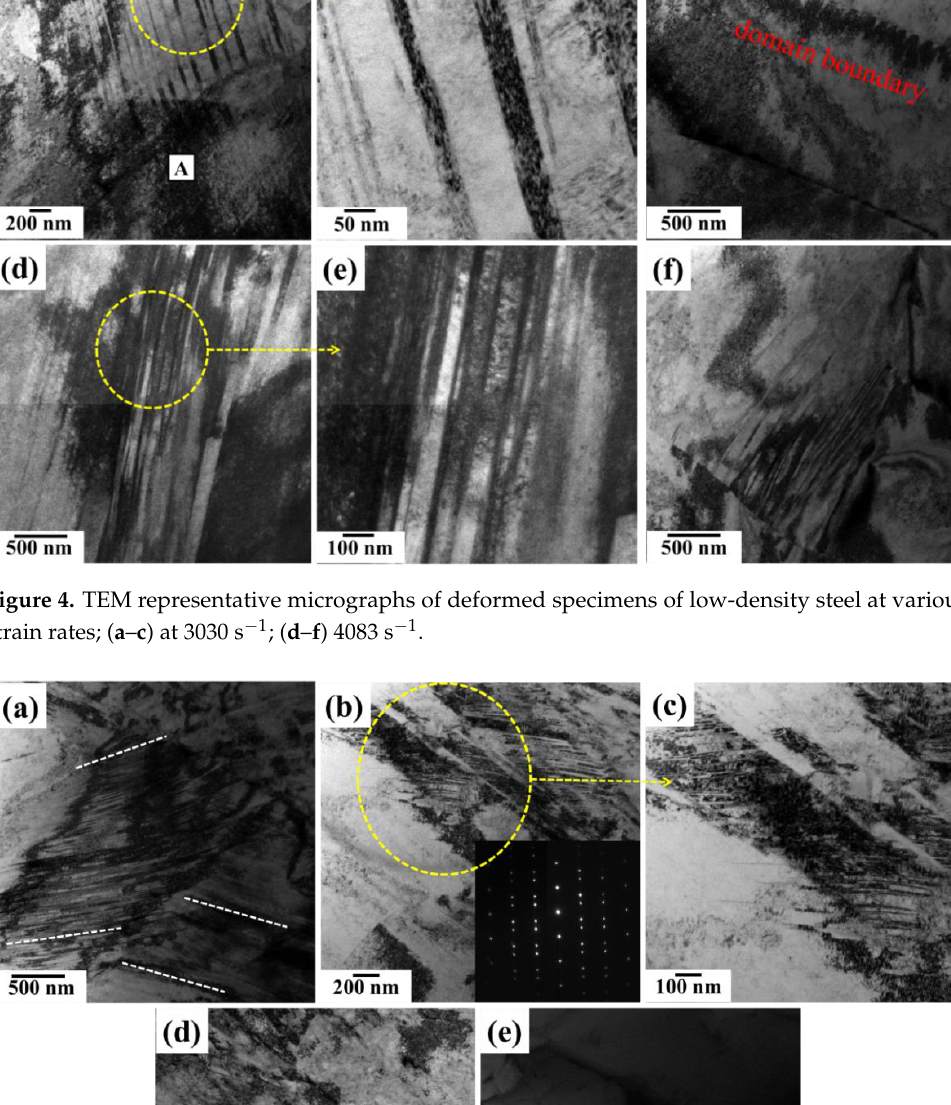
Figure 4. TEM representative micrographs of deformed specimens of low-density steel at various strain rates; ( a – c ) at 3030 s − 1 ; ( d – f ) 4083 s − 1 .